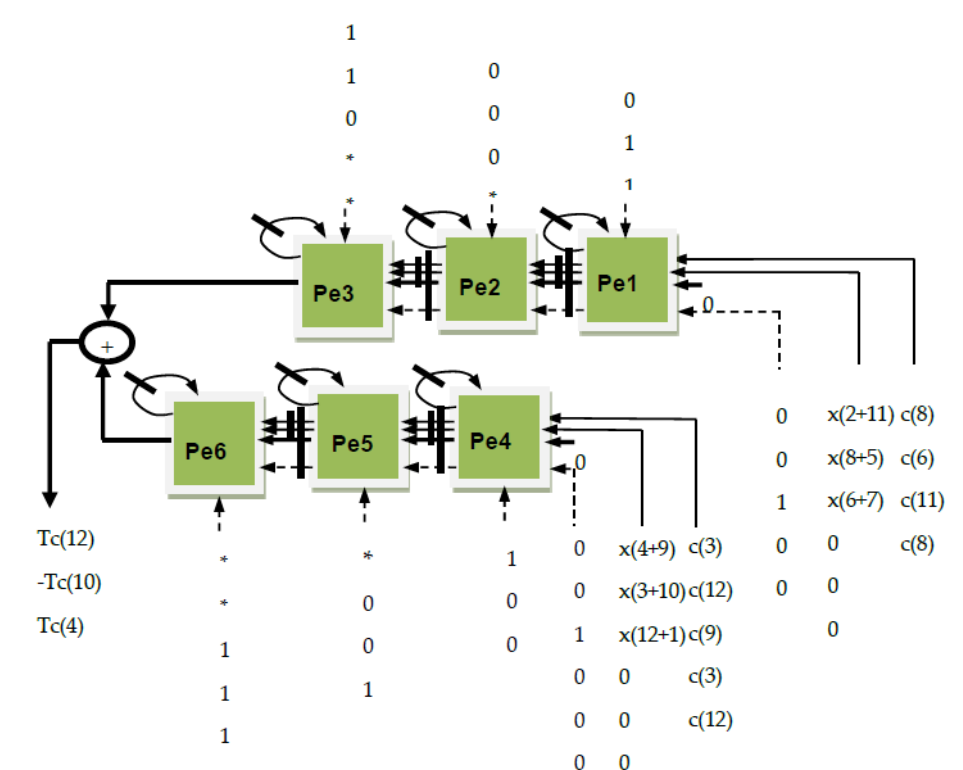
Figure 3. The VLSI architecture of the hardware core that implements Equation (10), where * marks a delay of one clock cycle [26].